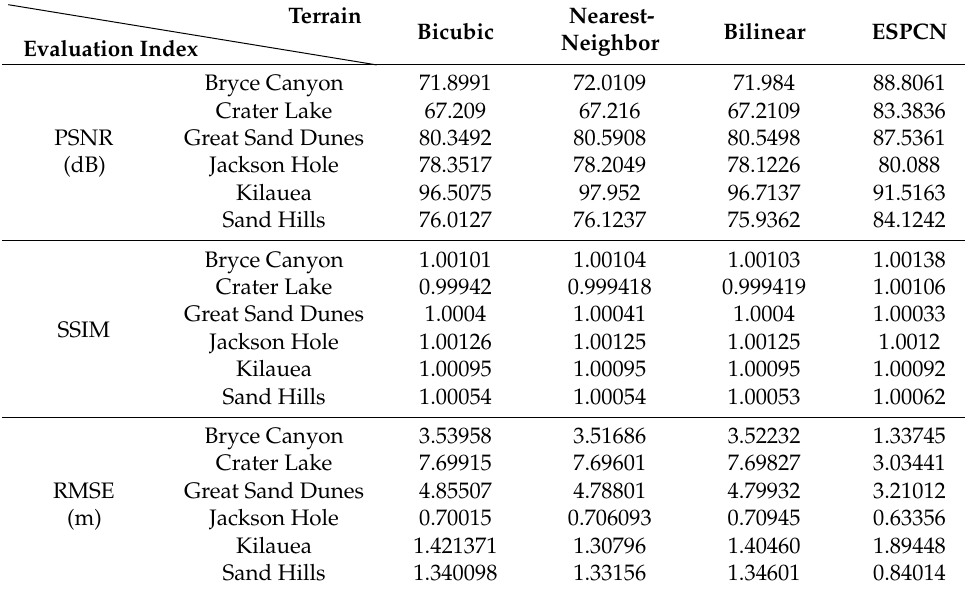
Table 5. Accuracy of SR-DEM with different